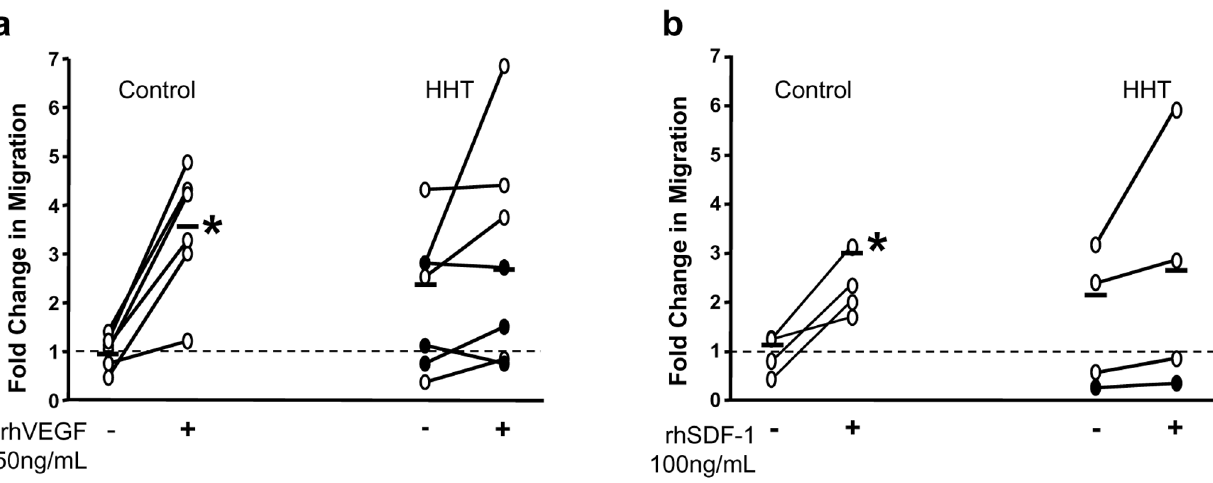
Figure 4. Suppressed cell migration towards VEGF and SDF1 in CACs from patients with HHT. Cell migration towards VEGF and SDF1 in healthy CACs increased by 4-folds and 3-folds, respectively, over the non-treated cells (a and b). In contrast, both VEGF and SDF1 induced HHT CAC migration was barely increased over the non-treated cells (a and b). * p , 0.05, compared with cells without VEGF or SDF1 treatment.